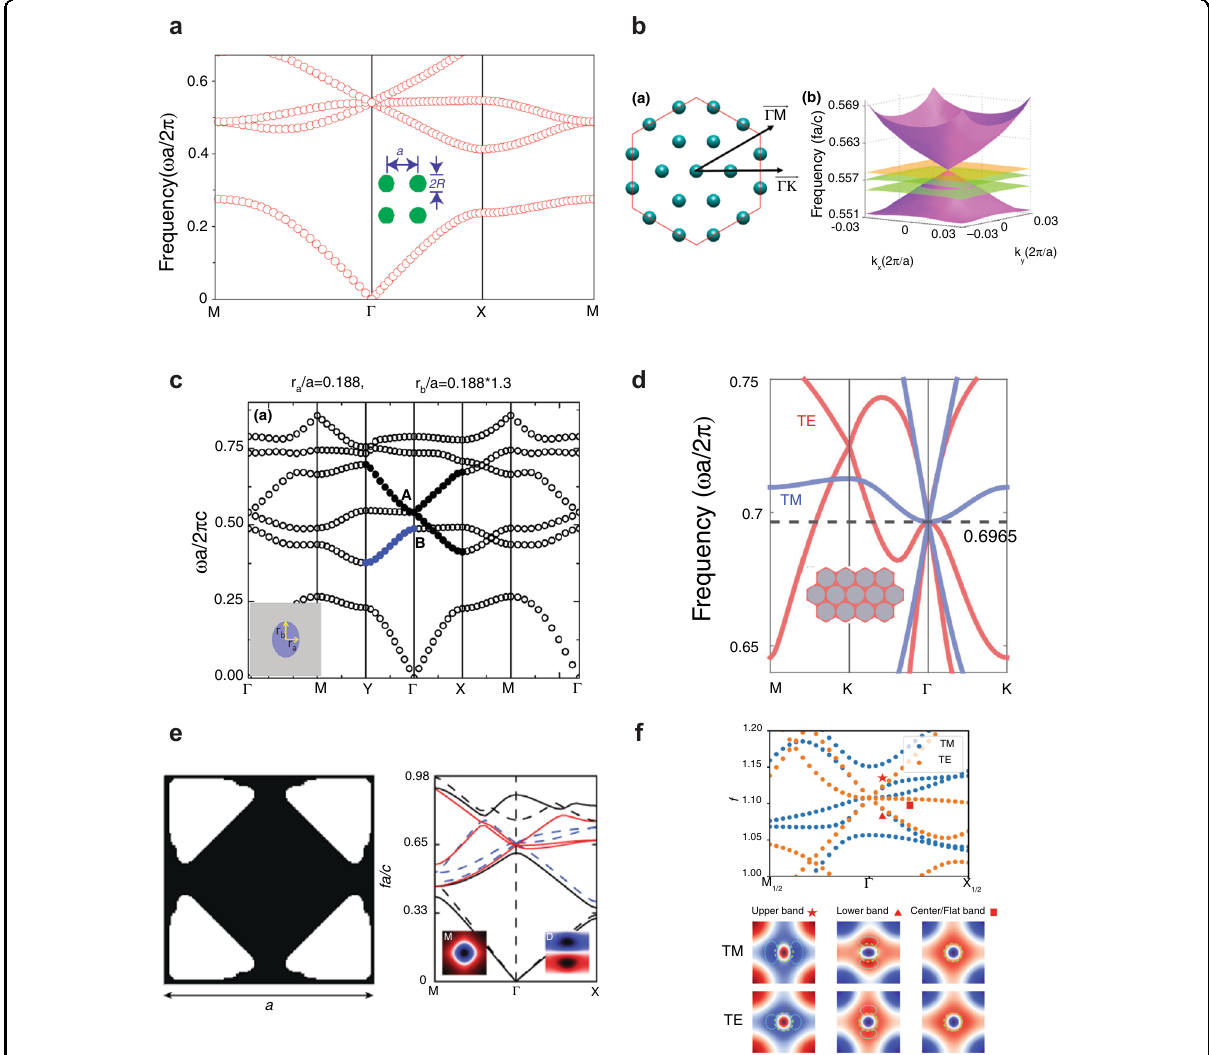
Fig. 3 Photonic bandstructure and schematic of different types of DCZIMs. Dirac-like cones based on a a 2D photonic crystal with a square lattice of dielectric rods and b a 2D photonic quasicrystal of dielectric rods. c semi-Dirac-like cone based on a square lattice of elliptical dielectric rods. Full-polarization Dirac-like cones based on d a hyper-crystal consisting of dielectric rods in an elliptic metamaterial, e a photonic crystal designed by using topology optimization, f a square lattice of dielectric rods. Figure adapted with permission from: a ref. 21 , Springer Nature Limited; b ref. 70 , APS; c ref. 71 , © The Optical Society; d ref. 76 , Springer Nature Limited; e ref. 52 , APS; f ref. 54 , © The Optical